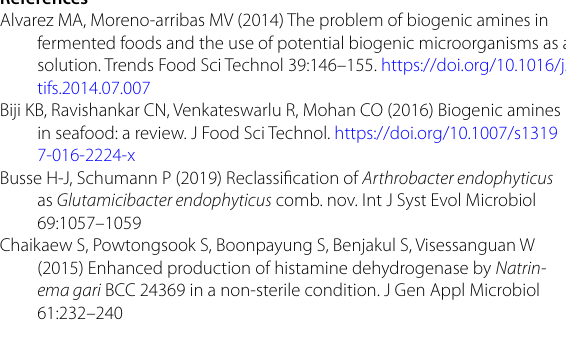
in Glutamicibacter sp. N1A3101 Experiment